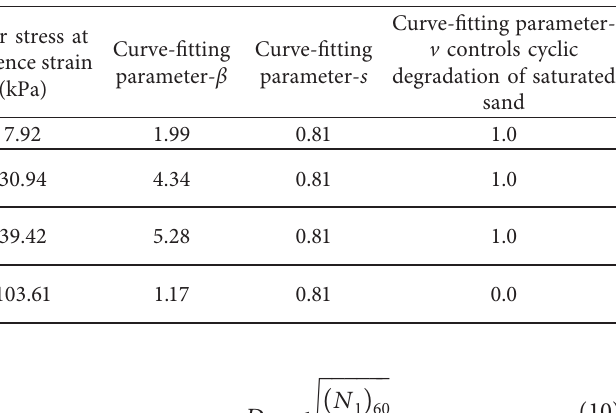
Table 1: The thickness of soil layers and the soil